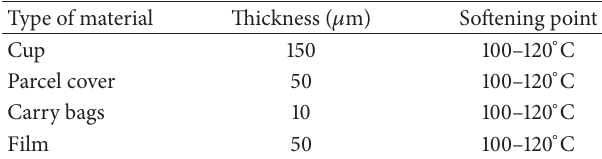
Table 4: Properties of